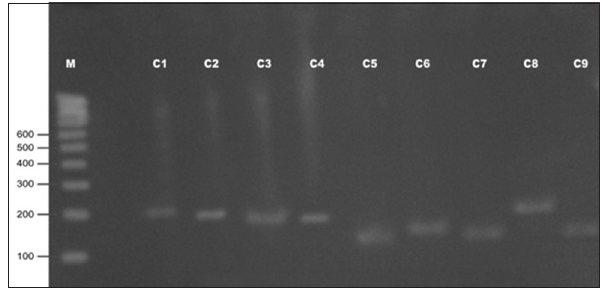
Figure-1: Polymerase chain reaction amplicons of spa gene (X-region) of Staphylococcus aureus isolates from Holstein–Friesian crossbred cattle (C1-C9) with subclinical mastitis.